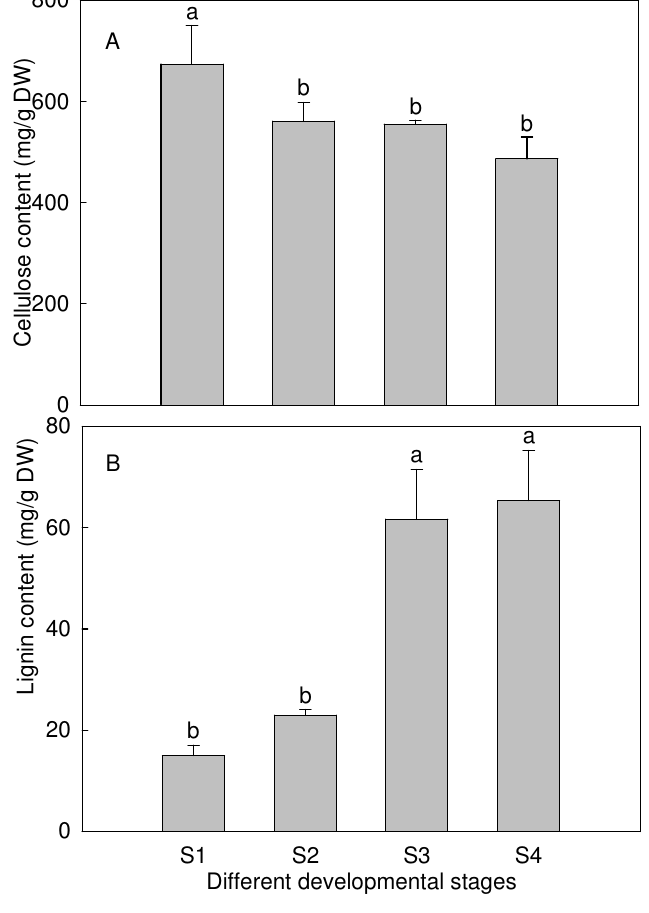
Figure 3. Cellulose and lignin contents of inflorescence stem. ( A ) Cellulose content of inflorescence stem; ( B ) Lignin content of inflorescence stem. a,b indicate significant difference at the 0.05